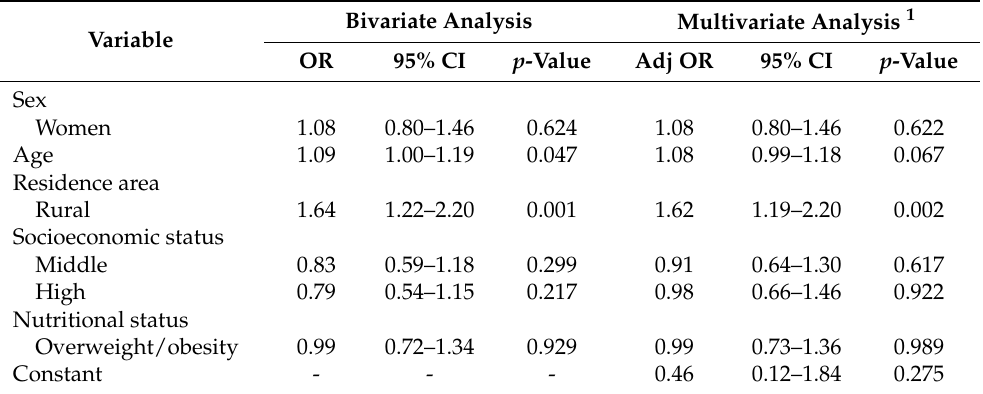
Table 4. Bivariate and multivariate logistic regression analysis: Sociodemographic variables related to having a diverse diet, according to Diet Diversity Score (DDS) ( n = 818). Bivariate Analysis Multivariate Analysis 1